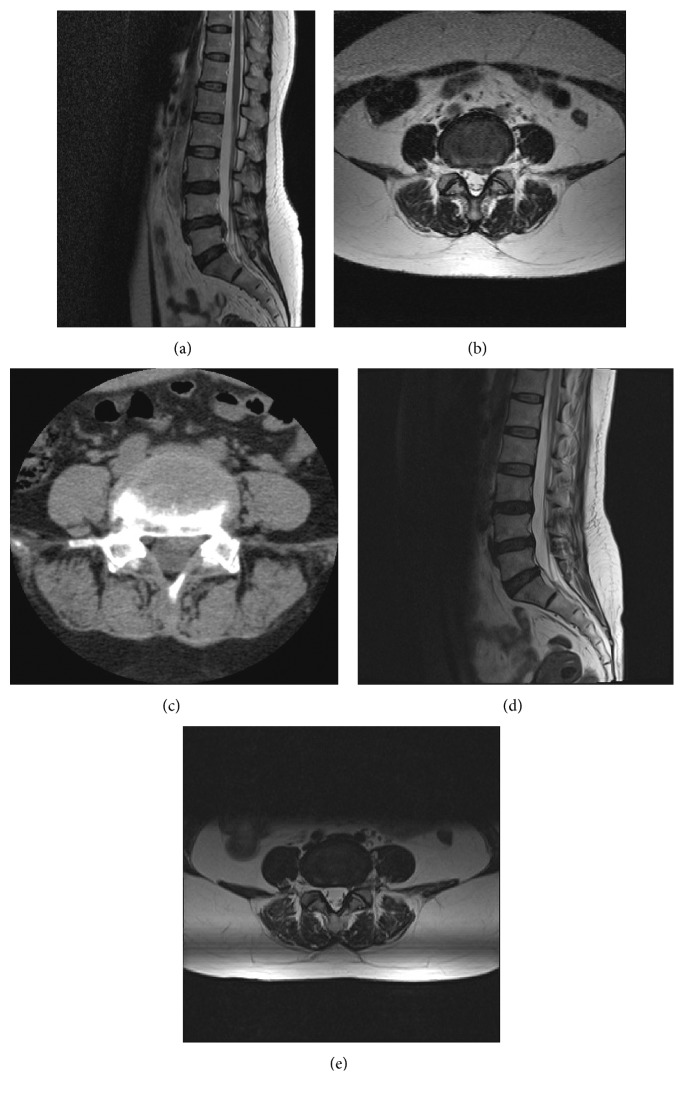
The preoperative and postoperative imaging data of patient who received TF PELD. (a and b) A preoperative MRI image shows the sagittal and coronal views of a patient diagnosed with LDH. (c) A preoperative CT image of the same patient. (d and e) The postoperative MRI sagittal and coronal views of the patient after TF PELD.